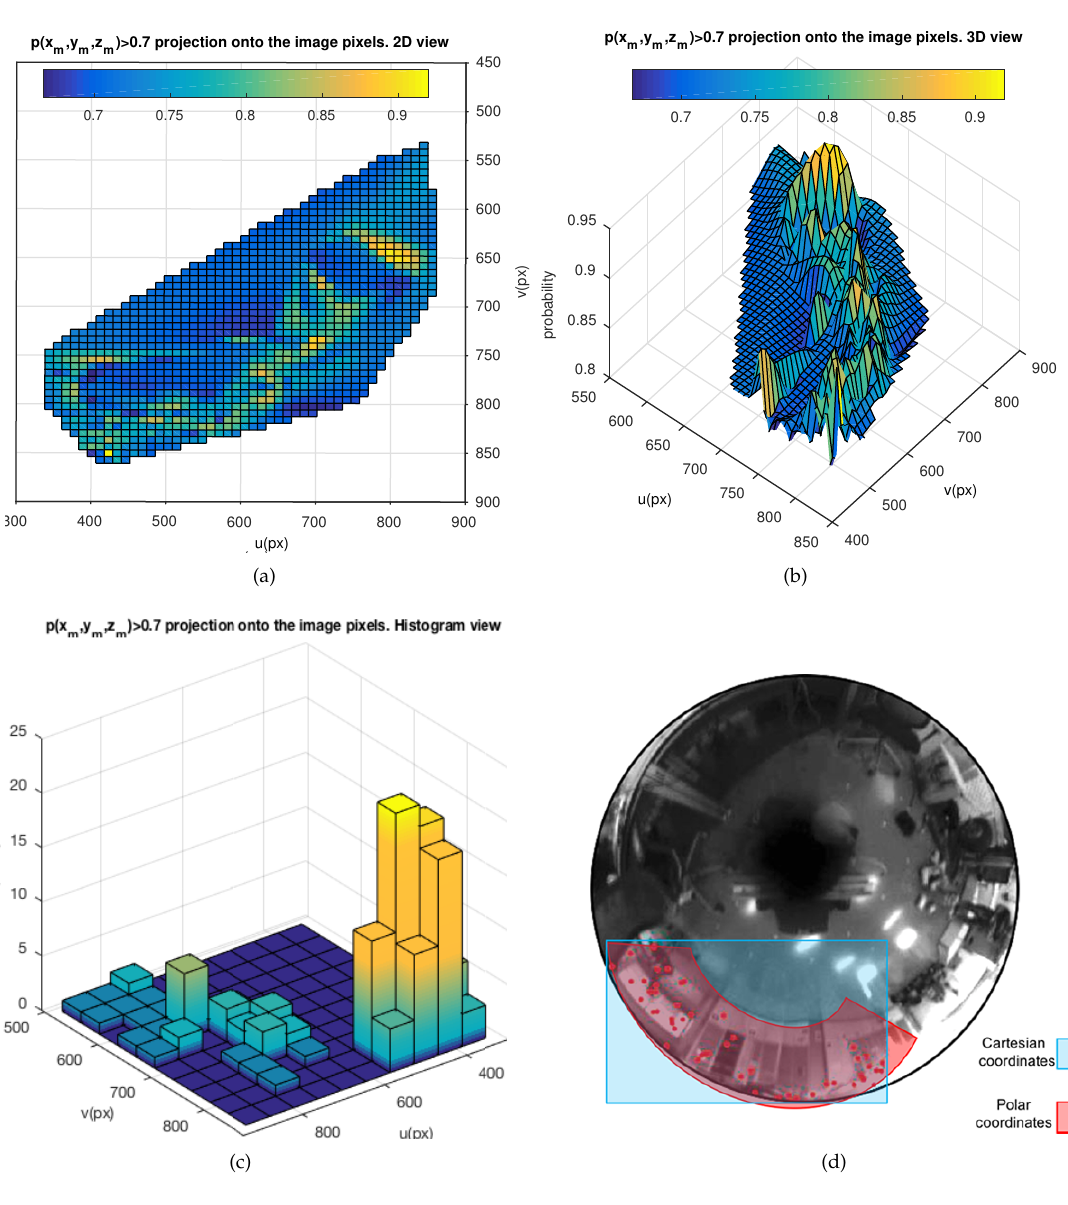
Figure 9. Projection of the 3D sampled probability distribution of feature existence, p ( x m , y m , z m ) ∈ [0.7–1], onto the image pixel axes, in t . ( a ) 2D representation, p ( u m , v m ) . ( b ) 3D representation with Z -axis expressing probability, p ( x m , y m , z m ) . ( c ) 2D histogram representation. ( d ) Euclidean versus polar